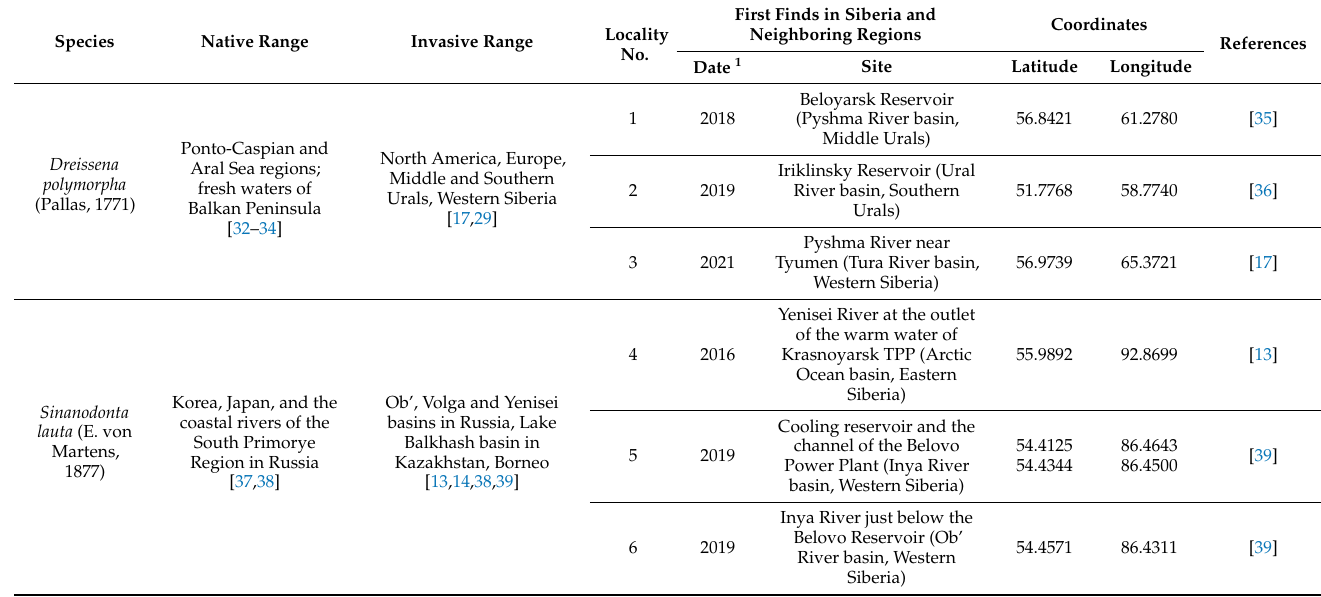
Table 1. A list of neobiotic species of freshwater Mollusca registered in Siberia, with remarks on their distribution and the dates of the first registration in the studied